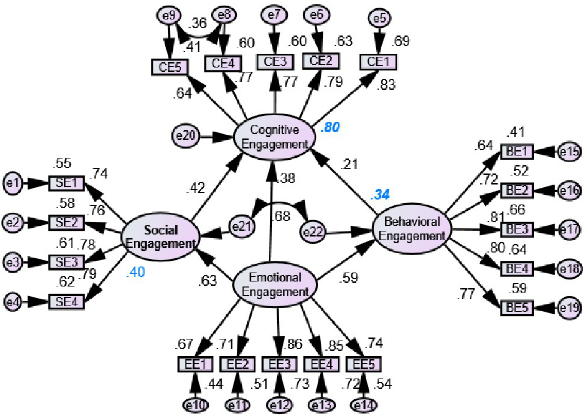
Fig 6. Effect of behavioral, emotional and social engagement on cognitive engagement (Model